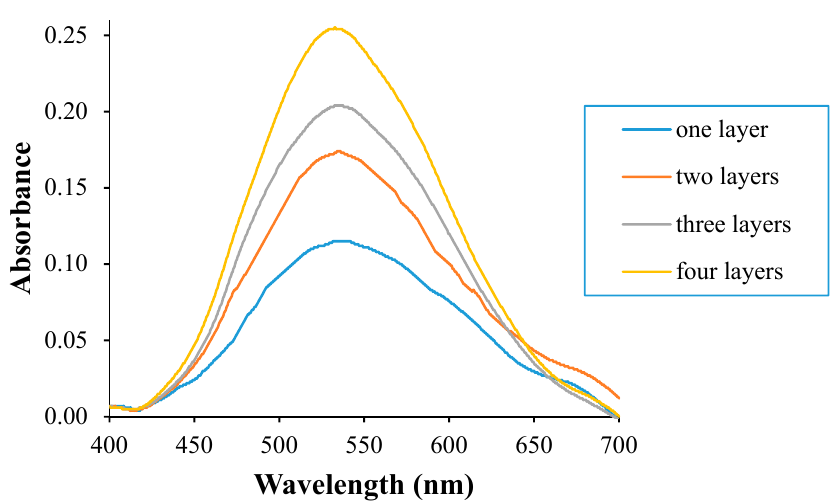
Figure 2. UV–Vis spectra of each pectin/chromoionophore (Pe/CI) optical pH sensor layer. An increasing number of layers increases absorbance.